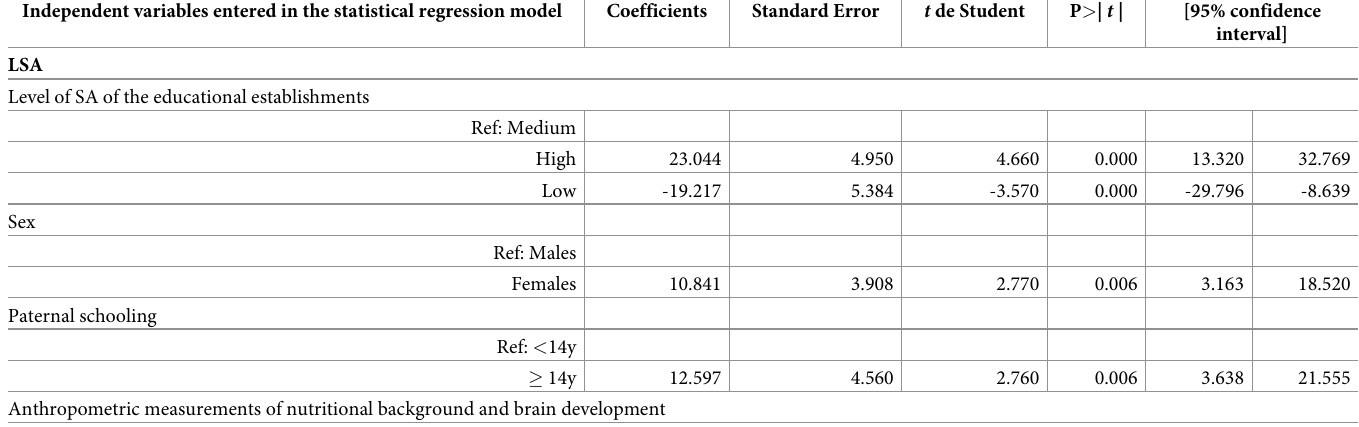
Table 2. Multiple regression models between language (LSA) and mathematics (MSA) scholastic achievement (SA) in the Education Quality Measurement System (2009 SIMCE) tests (dependent variables) and most relevant independent variables in school-age children of the 2010